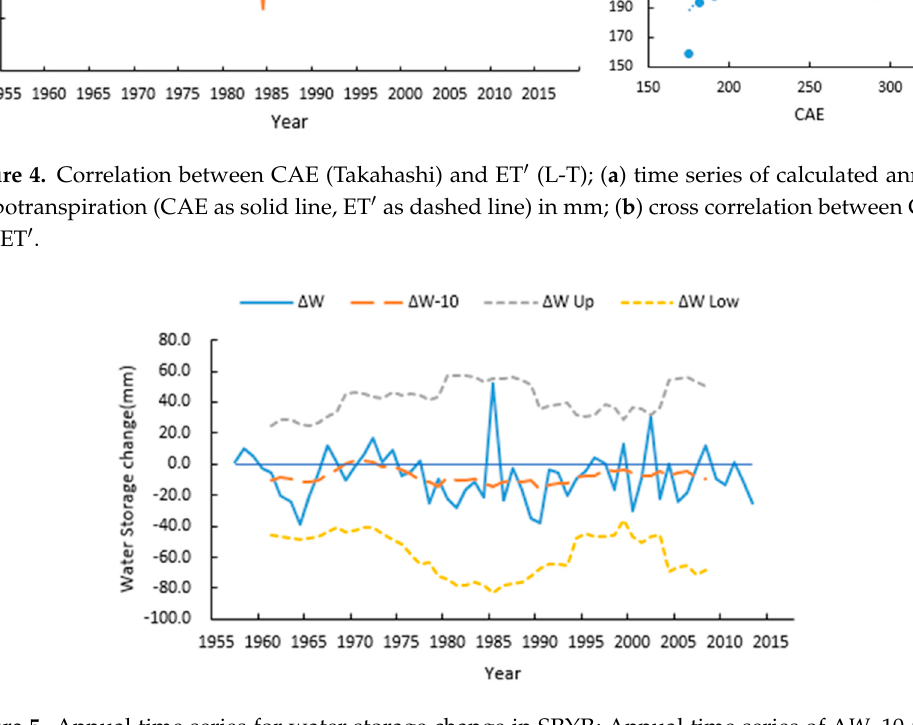
Figure 6. Correlation between monthly precipitation and runoff and temperature and runoff in SRYR; T ‐ R is correlation between temperature and runoff depicted by a dashed blue line; P ‐ R is correlation between precipitation and runoff depicted as solid orange line; significance level 0.05 is depicted as green dot line, positive correlation above green line is statistically significant. As climate is undergoing a rapid change, especially in recent decades, correlation between variables will also change. The entire time series was divided into two periods (1957–1990, 1991–2013), with changing points included in the second period. Correlation between precipitation, temperature, and runoff are shown for both periods in Figure 7. Change point analyzer showed that annual temperature and precipitation have a changing point at 1997 and 2004, with 99% and 95% significance levels respectively. As seen from Figure 7a, the relative influence from temperature increased during